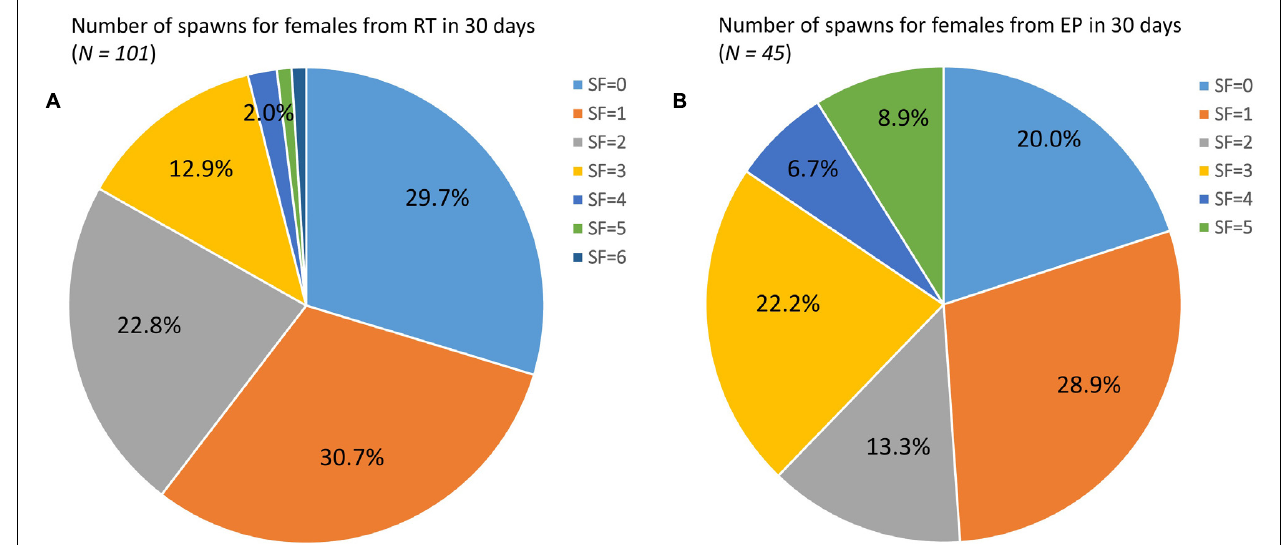
FIGURE 1 | Pie charts showing the number of spawns for (A) 101 female L. vannamei broodstock in the recirculating tank treatment (RT) and (B) 45 females in the earthen pond treatment (EP), over a 1 month trial.